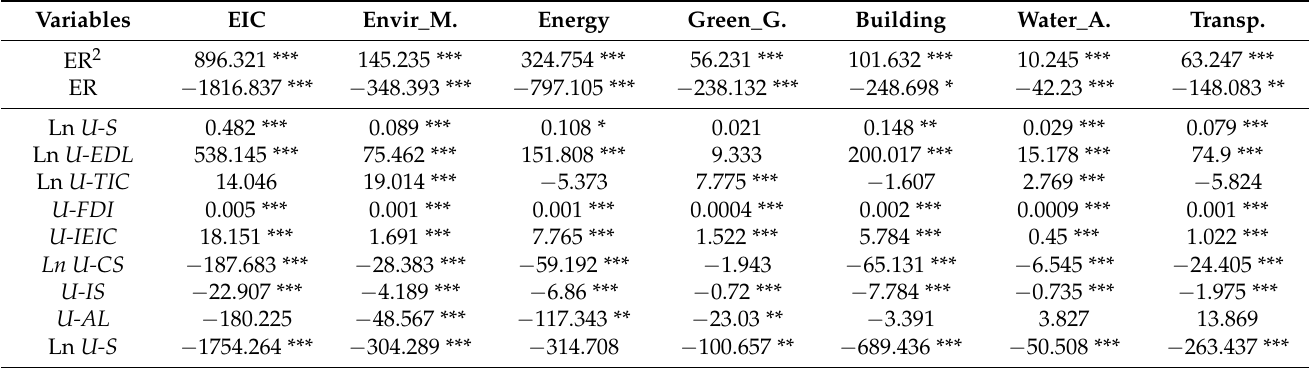
Table 8. Regression results of the random effects model.